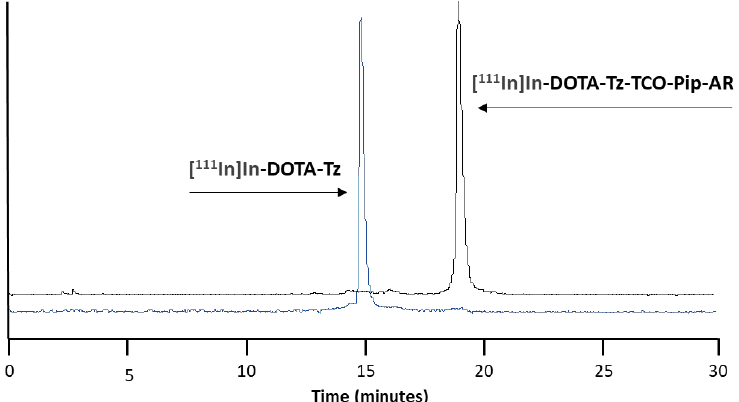
Figure 2. Synthesis of the 111 In-radioconjugates by click reaction between the clickable antagonists AR-PEG 4 -TCO and AR-Pip-TCO and the clickable radiocomplexes [ 111 In]In-DOTA-Tz and [ 111 In]In -DOTAGA-Tz.